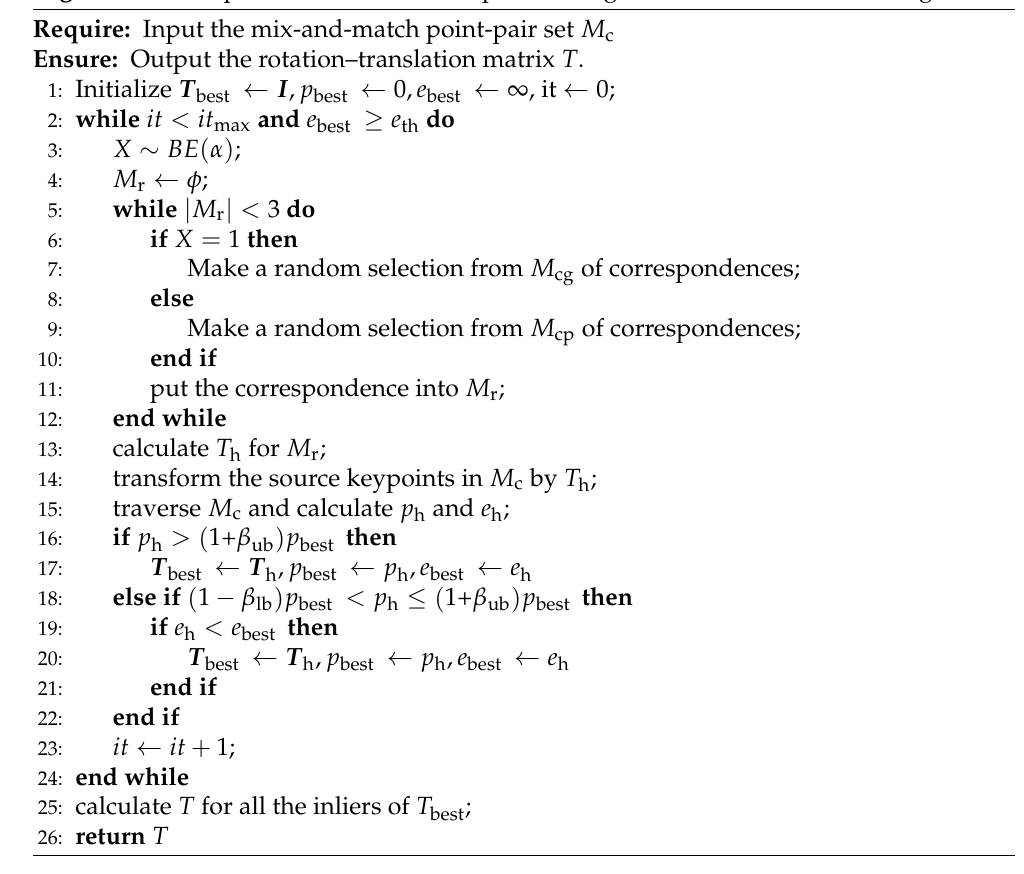
Algorithm 1 The pseudocode for the adaptive 3D registration method for